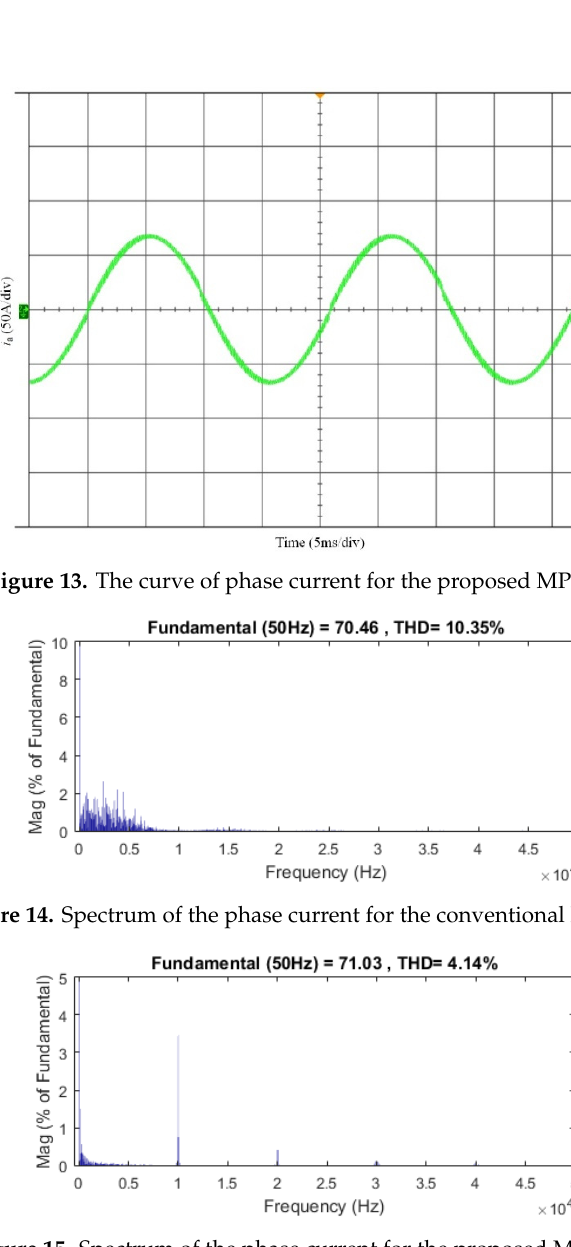
Figure 15. Spectrum of the phase current for the proposed MPDTC.